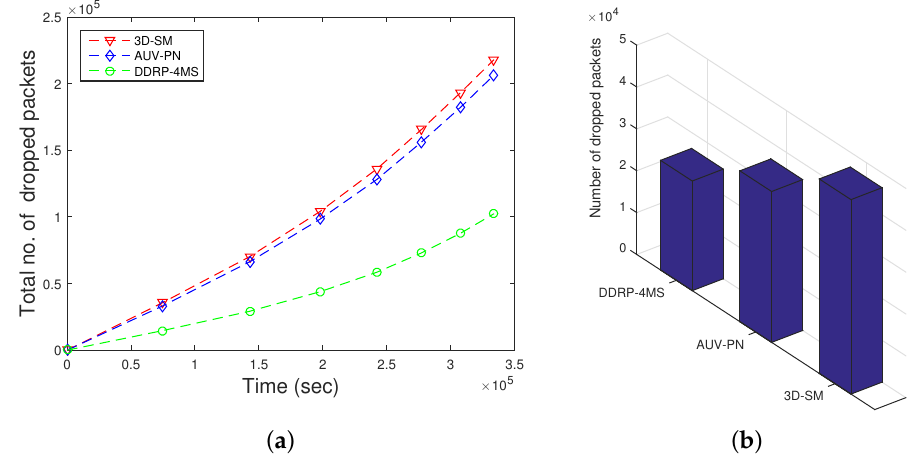
Figure 10. Dropped packets. ( a ) when all nodes die; ( b ) when first node